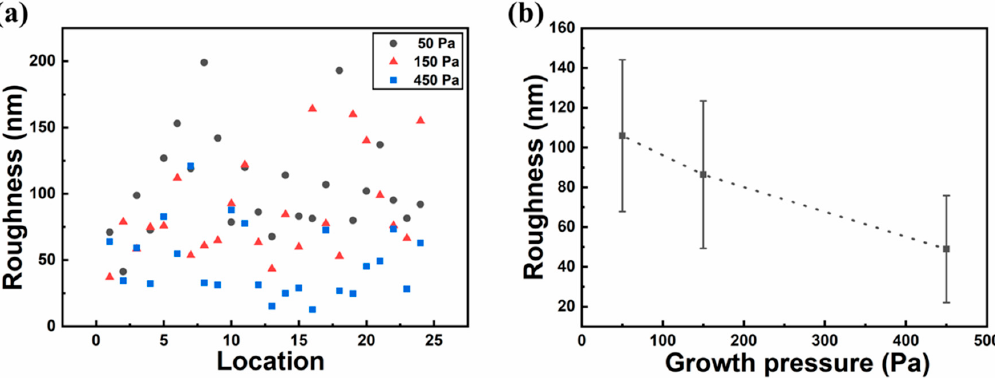
Figure 4. Statistical analysis of the variation of inner surface roughness of copper pockets with growth pressure. ( a ) The roughness values of 24 different locations on the inner surface of each copper pocket under 50, 150, and 450 Pa. ( b ) The relationship between growth pressure and the inner surface roughness of the copper pockets.